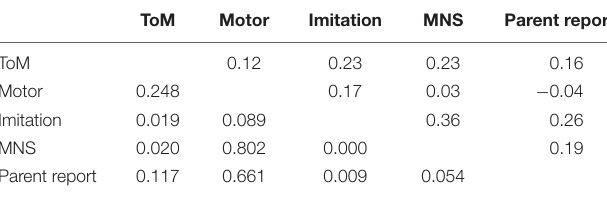
Upper triangle indicates correlation coefficient, lower triangle indicates p-values.